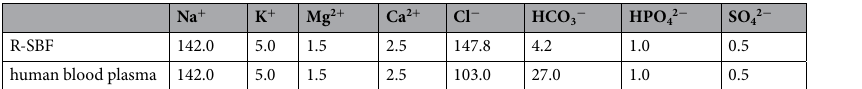
Table 3. Nominal ion concentrations (mM) of the used standard simulated body fluid